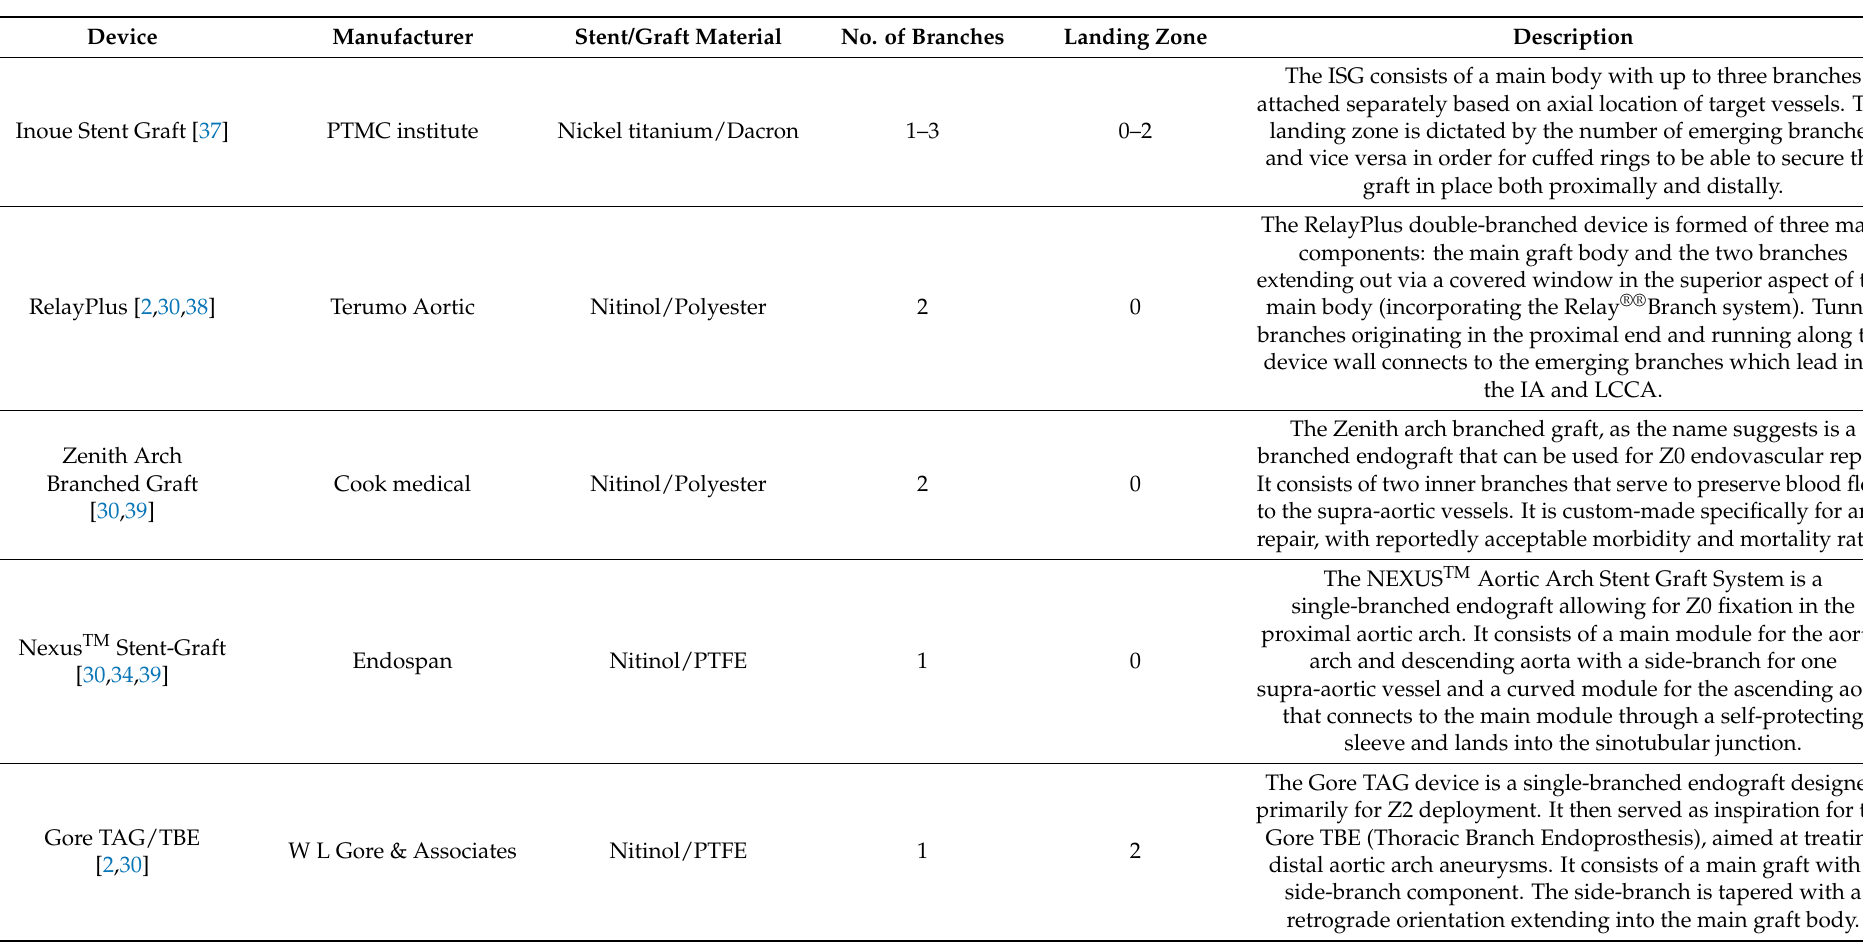
Table 1. A brief overview of some commercially available